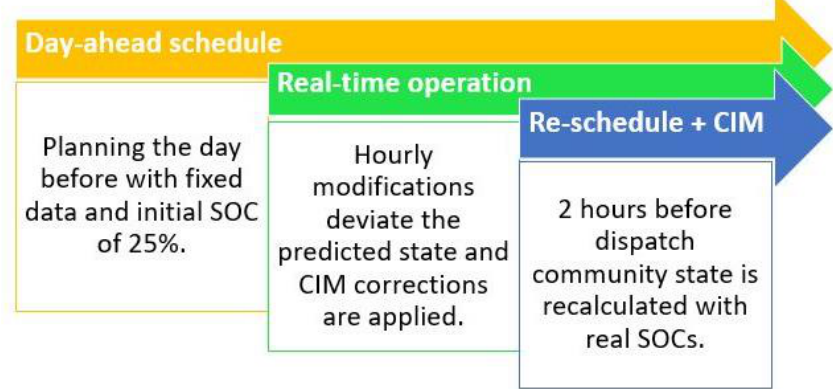
Figure 5. DM bidding and real-time superposition timeline.